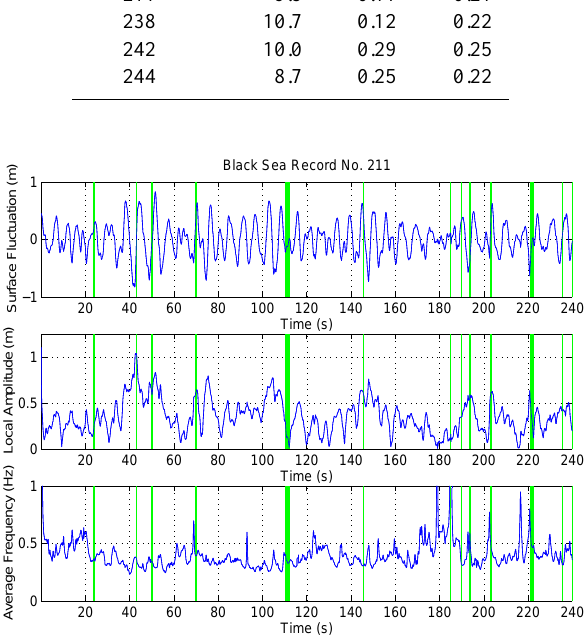
Fig. 1. Black Sea sample results. Vertical bars indicate breaking